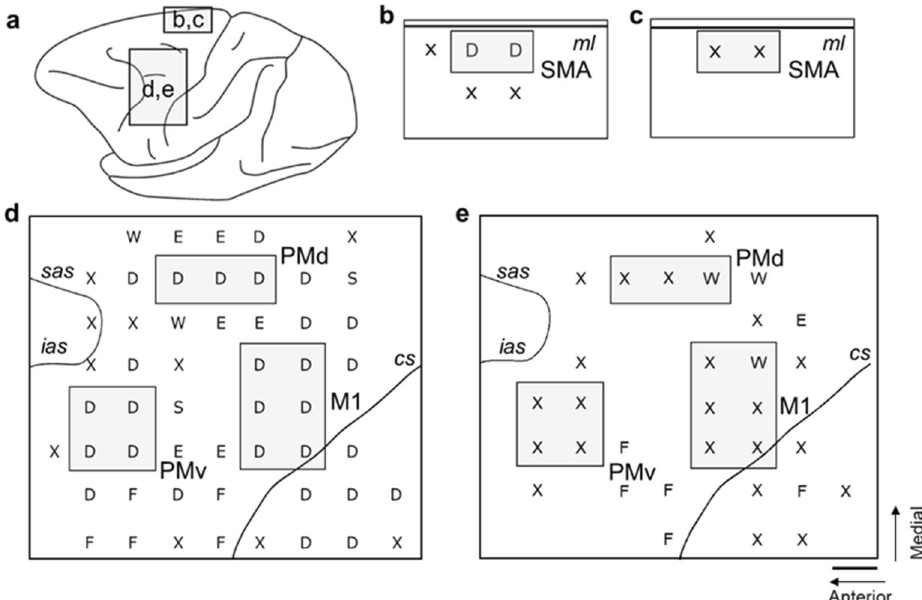
Figure 1. ICMS mapping of frontal motor-related areas in a monkey SCI model. ( a ) Lateral view of the monkey brain showing the cortical areas examined by ICMS. ( b , c ) Results of ICMS mapping for identification of digit representation of the SMA before SCI ( b ) and 10 days after SCI ( c ) in Monkey C. ( d , e ) Results of ICMS mapping for identification of digit representations of the M1, PMd, and PMv before SCI ( d ) and 10 days after SCI ( e ). Scale bar, 2 mm. The identified digit regions (in gray) are taken for morphological analyses of large layer V pyramidal neurons (i.e., putative CST neurons). The body parts of which movements were evoked by ICMS are indicated as follows: D, digits; E, elbow; F, face; S, shoulder; W, wrist; X, no response. cs, central sulcus; ias, inferior limb of the arcuate sulcus; ml, midline; sas, superior limb of the arcuate